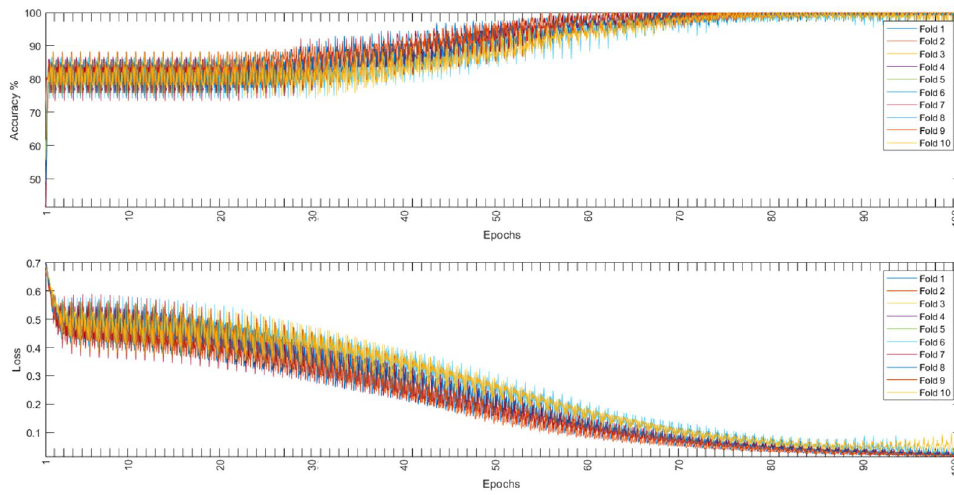
Figure 11. Binary dataset training accuracy and loss.